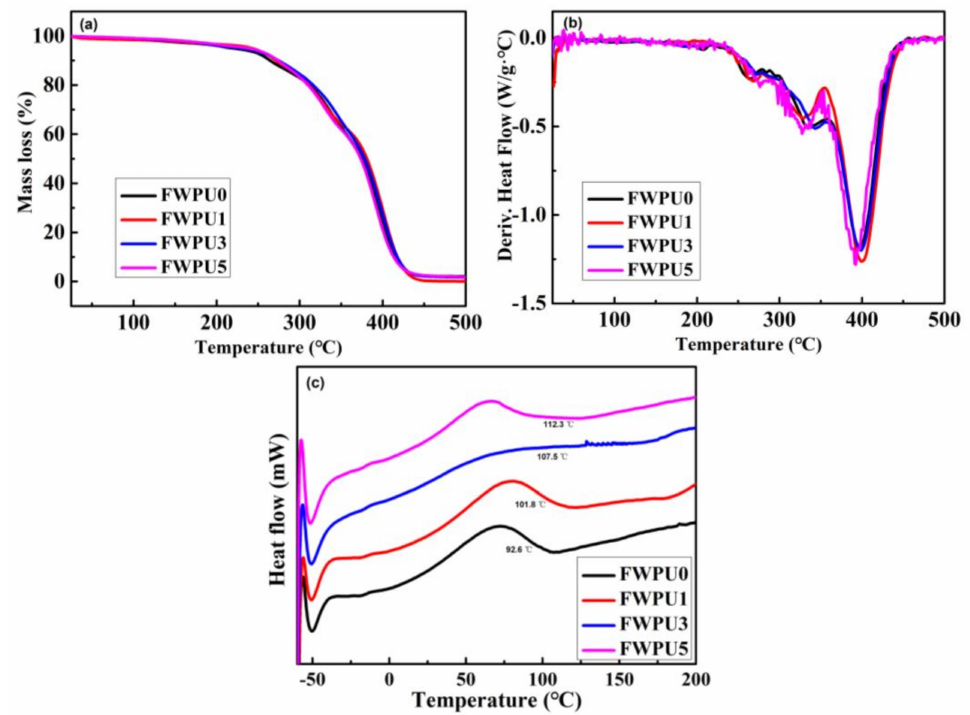
Figure 3. The TGA ( a ), DTG ( b ) and DSC ( c ) curves of waterborne polyurethane films with different POSS